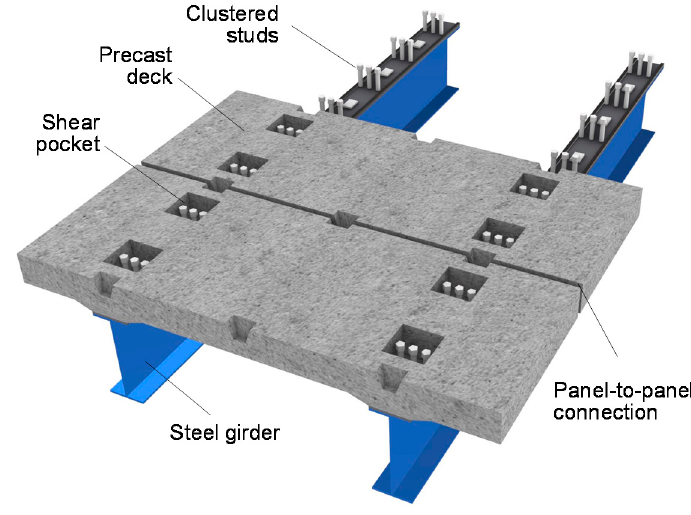
Figure 1. Schematic of full-depth precast concrete deck panel system.